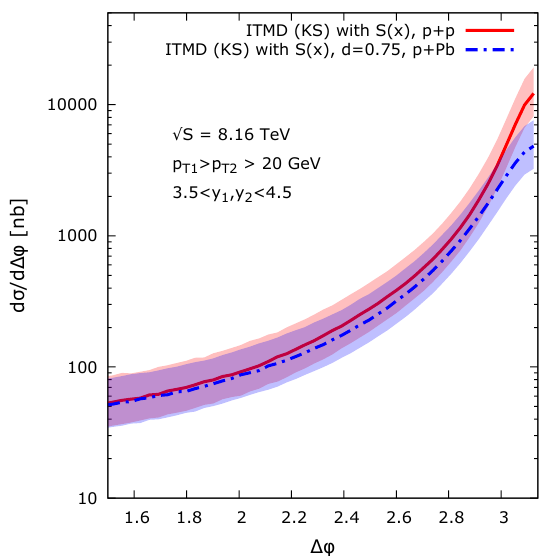
Figure 2 . Di(cid:11)erential cross section as a function of the azimuthal angle between the jets for p+p and p+Pb collisions (rescaled by the number of nucleons). The distributions are identical everywhere expect near (cid:1) (cid:30) ’ (cid:25) , where saturation is the strongest. The plot replaces (cid:12)gure 4 left in [1].